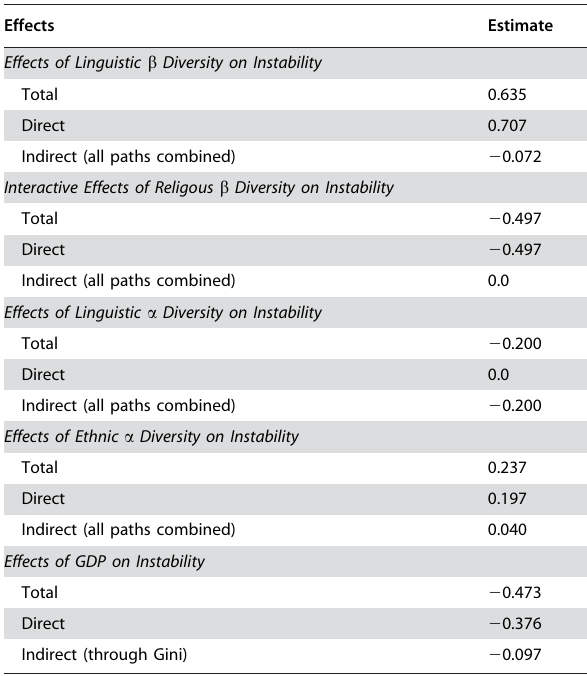
Table 1. Select standardized total, direct, and indirect effects